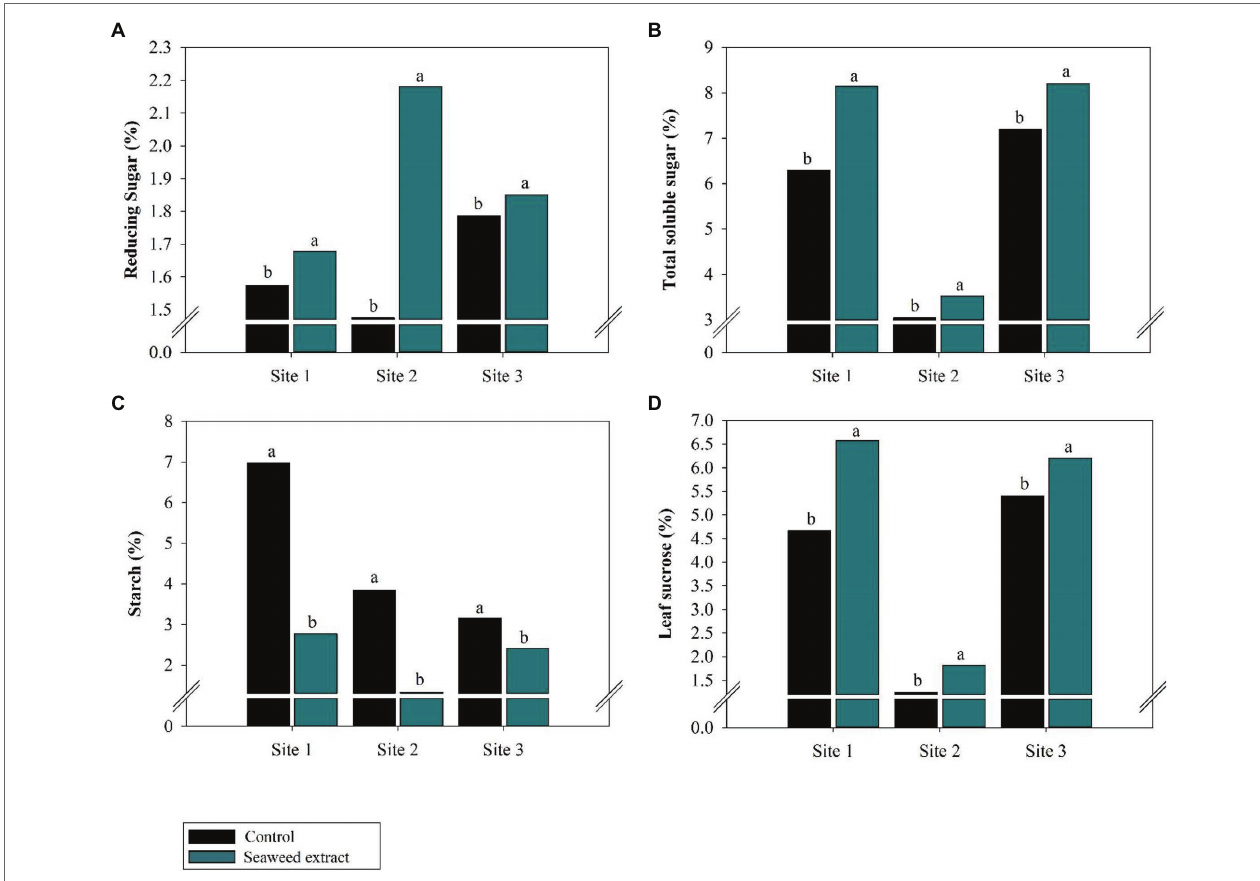
FIGURE 3 | Effects of seaweed extract (SWE) application on sugarcane leaf metabolic parameters at harvest: (A) reducing sugars (%), (B) total soluble sugars (%), (C) starch (%), and (D) leaf sucrose (%). The treatments were as follows: Control, no SWE application; Seaweed extract: application of SWE biostimulant based on Ascophyllum nodosum in the beginning of the drought season (July at site 1 and June at sites 2 and 3). Averages followed by the same letters do not differ by the LSD test ( p <